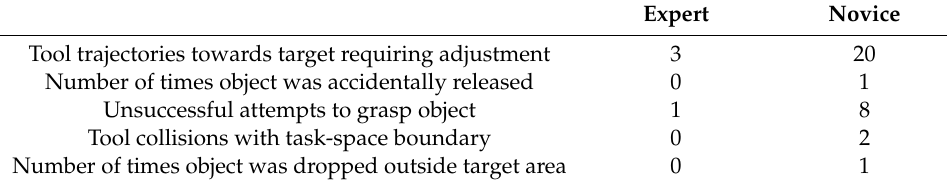
Table 6. Quantitative performance analysis relative to task precision of the expert and the novice.